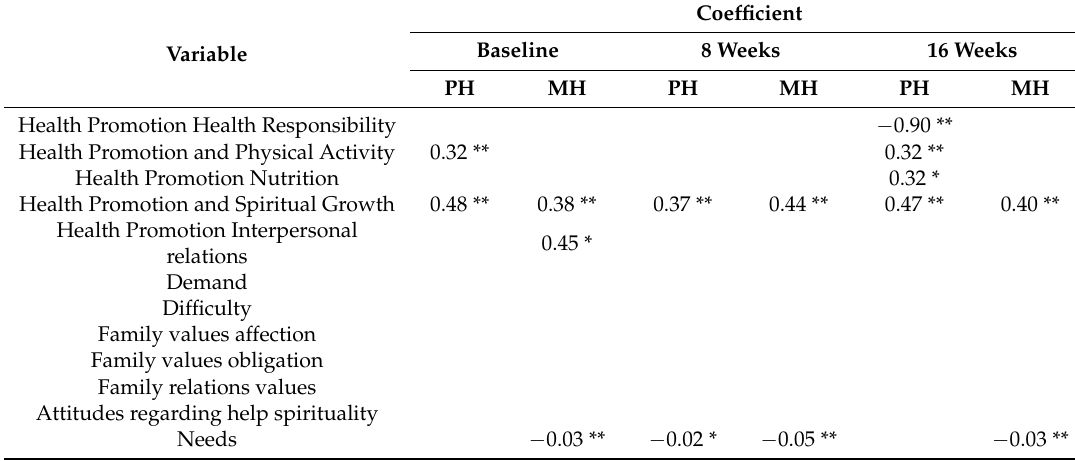
Table 3. Predictors associated with PH and MH by time; stepwise backwards linear regression final model for each time